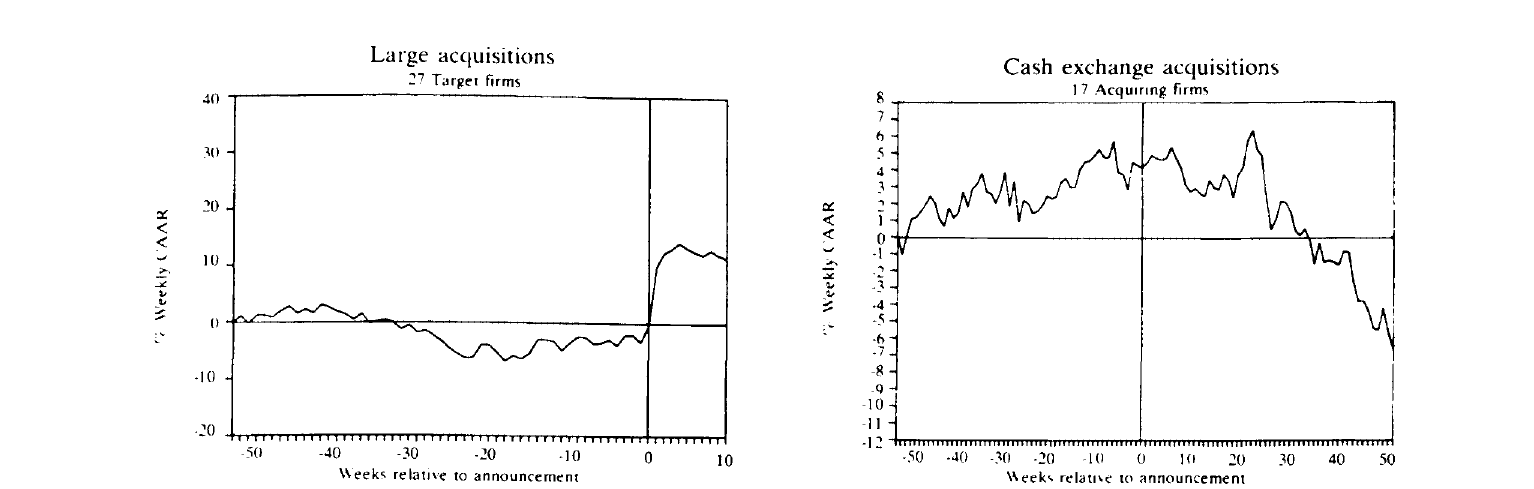
Figure 12 CAAR plot for target firms in large mergers (sample 3.1)